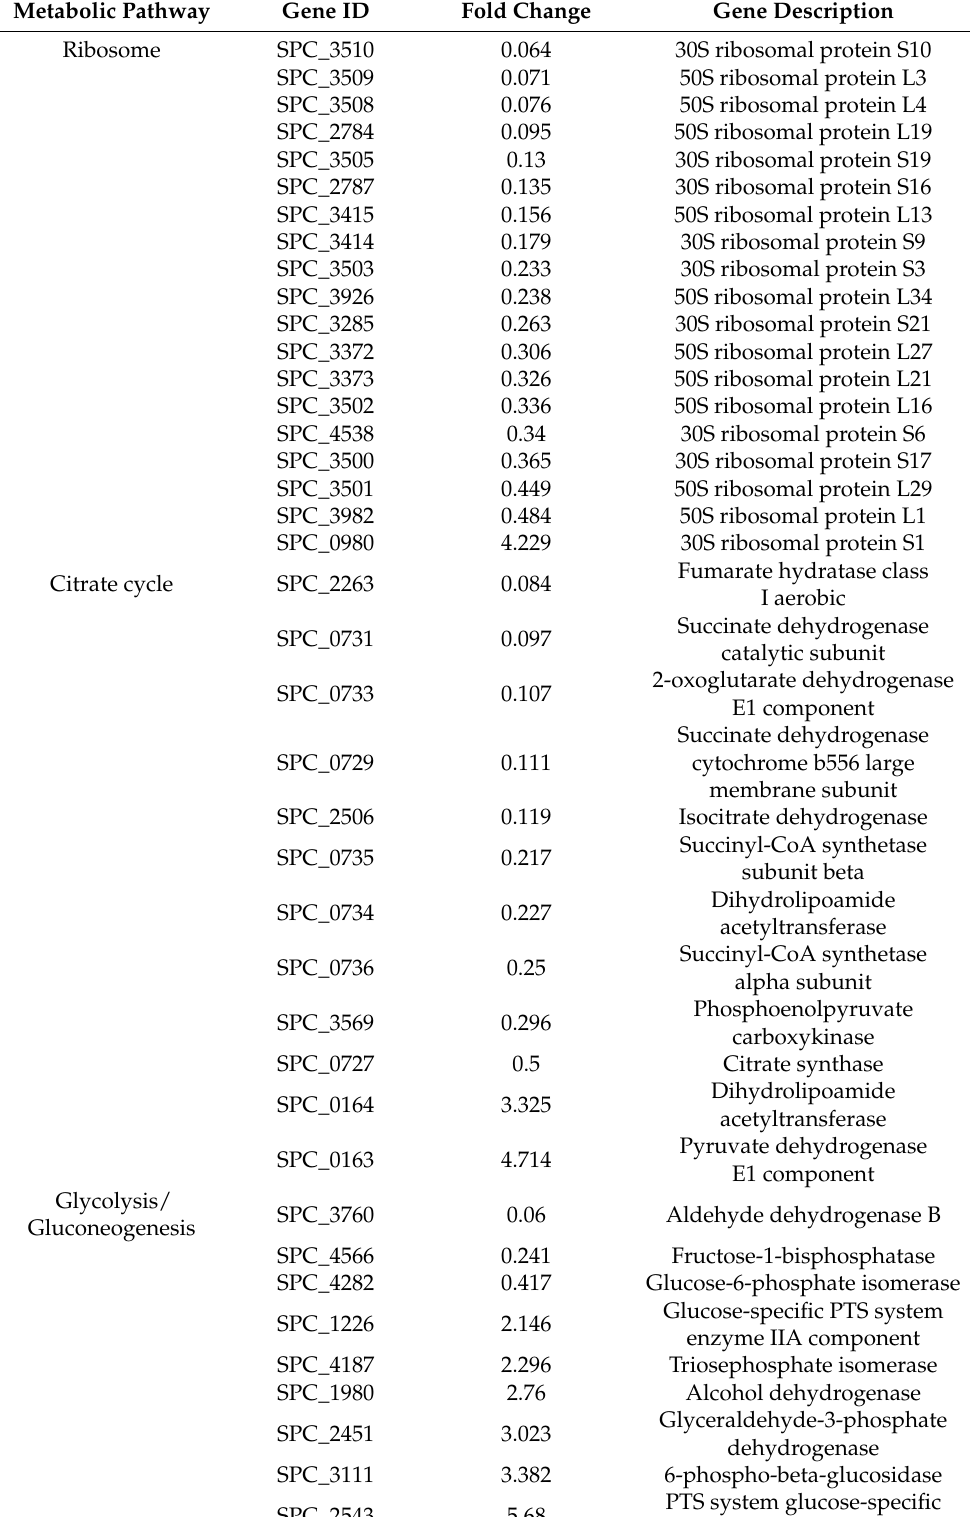
Table 4. The major altered metabolic pathways in S. enterica subsp. enterica ( ex Kauffmann and Edwards) Le Minor and Popoff serovar Vellore ATCC15611 mediated by Fragment 1 from C. communis